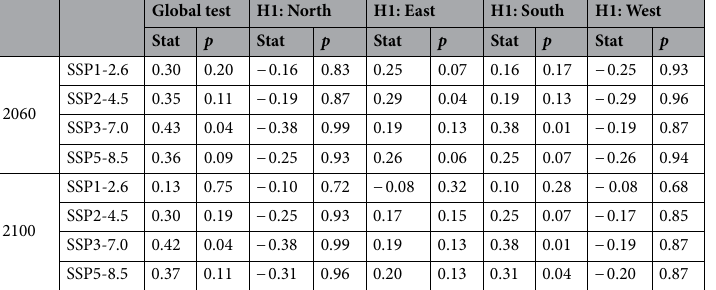
Table 3. Results from the Rayleigh circular tests to evaluate global directional changes or specifically testing the alternative hypothesis or north, east, south, and west directional potential shifts for Atlantic Forest endemic primate distributions. Projections for all Shared Socioeconomic Pathways (SSP1-2.6, the most optimistic one, SSP2-4.5, SSP3-7.0 and SSP5-8.5, the most pessimist one) and two times in the future (2060 and 2100) without considering potential dispersal are presented. Once L. rosalia does not have suitable areas in all 2060 and 2100 future scenarios, it was not included in this analysis (no centroid information). N = 18 in most scenarios, exceptions 2060 SSP1-2.6 (N = 17, L. caissara excluded because the centroid was the same as current), and 2100 SSP5-8.5 (N = 16, C. flaviceps and L. chrysopygus does not have suitable areas in this scenario).